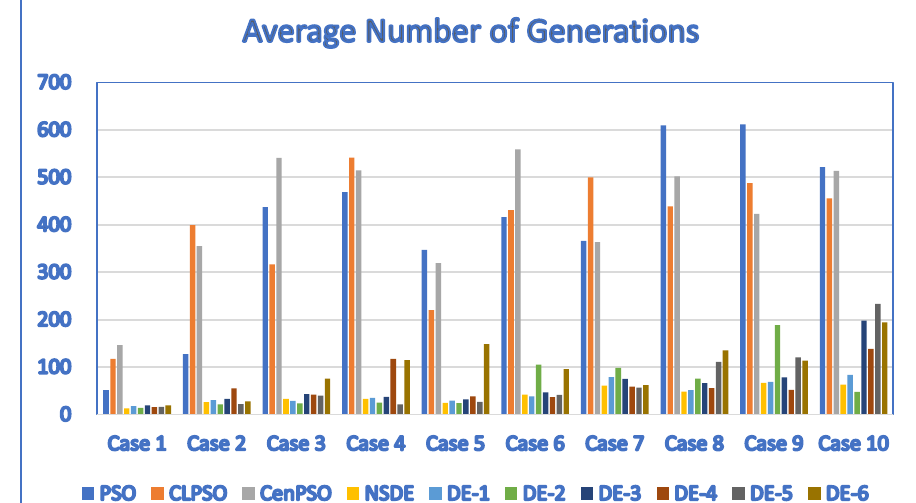
Figure 7. Average number of generations for D r = P r =0.1 when NP = 50.